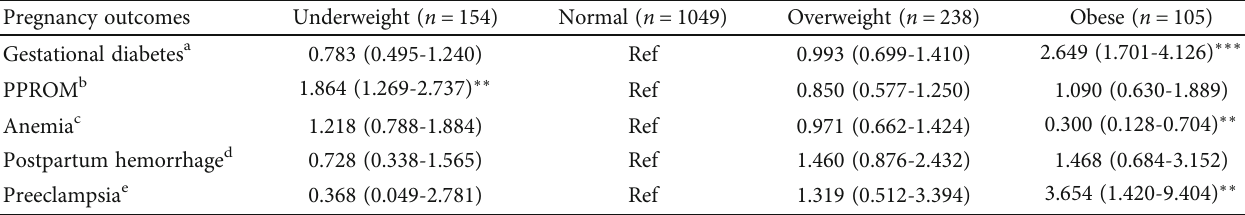
Table 5: Odds ratio for pregnancy outcomes by prepregnancy BMI